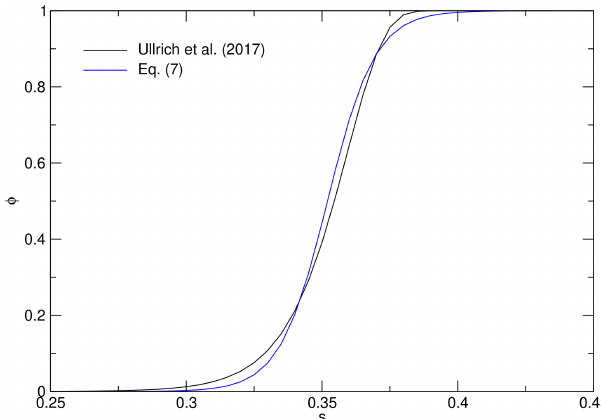
Figure A1. Comparison of an ice activation parameterization for 1µm dust particles (black curve) with an analytical approximation